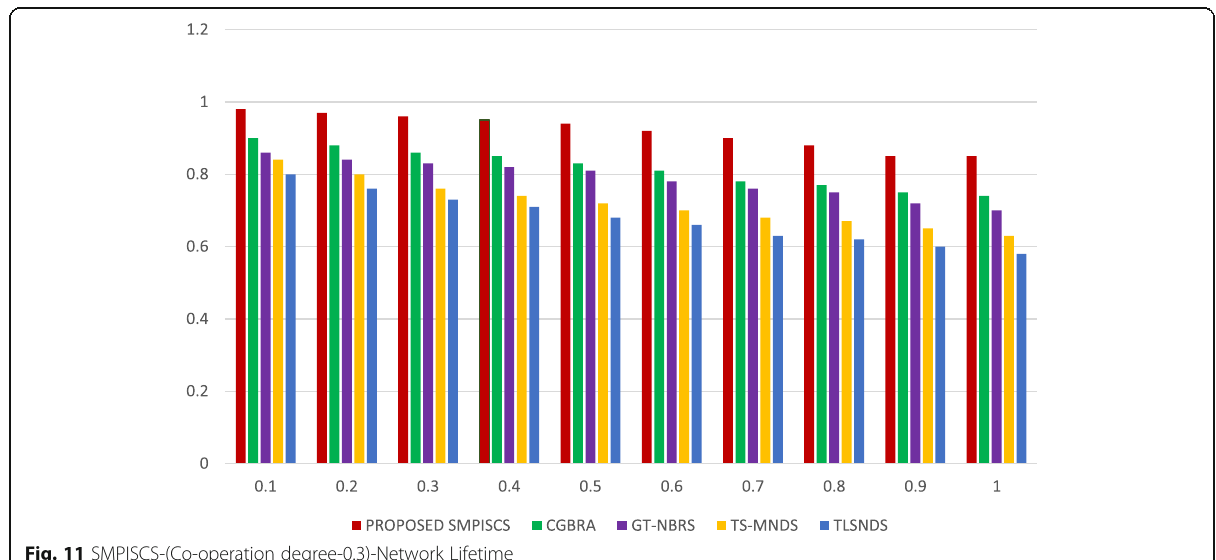
Fig. 11 SMPISCS-(Co-operation degree-0.3)-Network